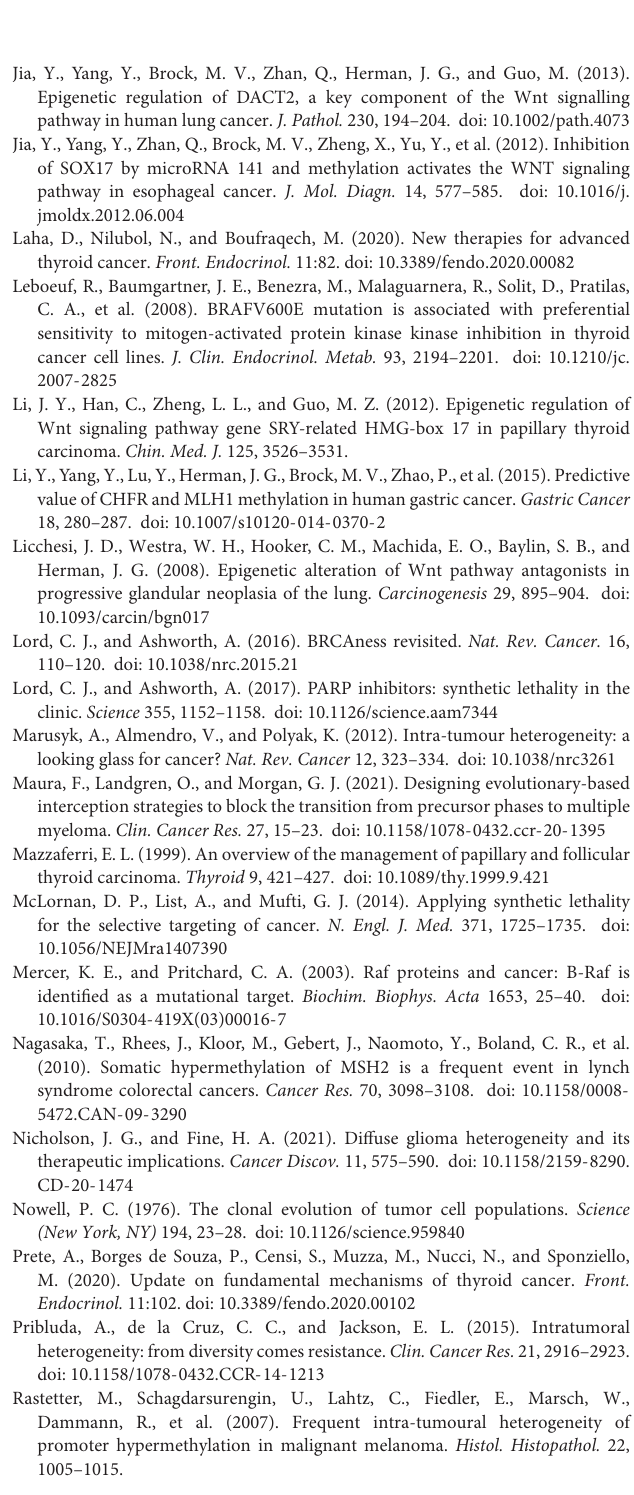
Supplementary Figure 1 | The workflow of epigenetic heterogeneity analysis. Supplementary Table 1 | Clinical factors of patients. Supplementary Table 2 | Primers used for methylation